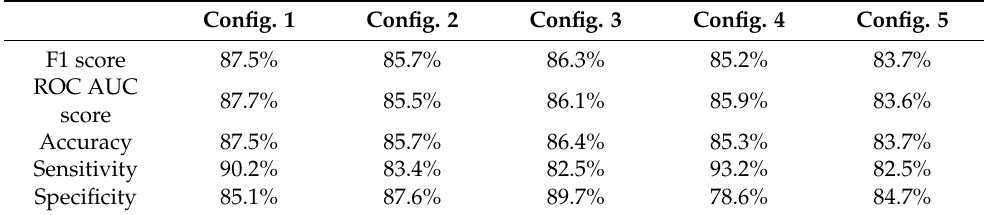
Figure 19. Accuracy and loss for Configuration 2, non-overlapping dataset. Table 10. Classification scores for Configurations 1–5, for the non-overlapping dataset.